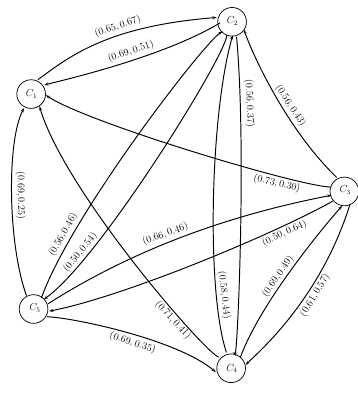
Figure 17. Partial directed network of the fused